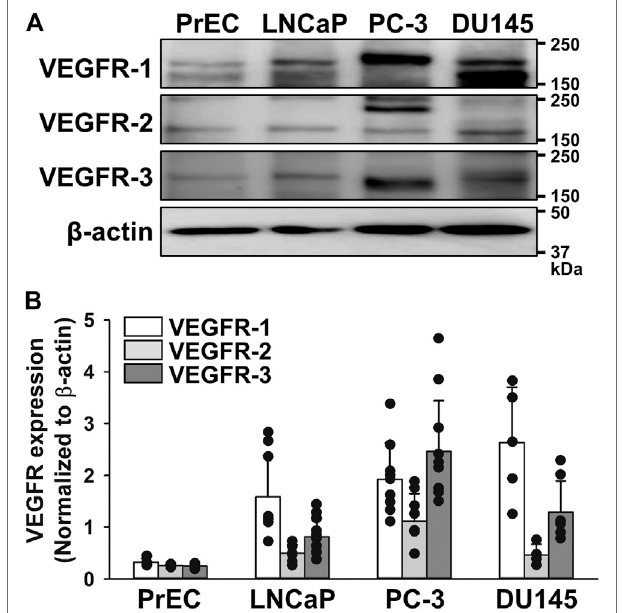
FIGURE 1 | Up-regulation of VEGFR-3 in human prostate cancer PC-3 cells. The protein expression of VEGFRs was examined in human prostate epithelial PrEC cells and prostate cancer LNCaP (androgen-dependent/ weakly metastatic), PC-3 (androgen-independent/highly bone metastatic), and DU145 (androgen-independent/moderate brain metastatic) cells by Western blotting. (A) Representative blots of VEGFR-1, VEGFR-2, and VEGFR-3 in PrEC, LNCaP, PC-3, and DU145 cells. β -actin was used as an endogenous marker. (B) Expression levels of VEGFR-1, VEGFR-2, and VEGFR-3in PrEC, LNCaP, PC-3, and DU145 cells( n (cid:1) 4 – 11). The expression levels of VEGFRs were normalized by that of β -actin. Note that the expression level of VEGFR-3 was higher in PC-3 cells than in PrEC, LNCaP, and DU145 cells. Data are presented as means ± S.D.